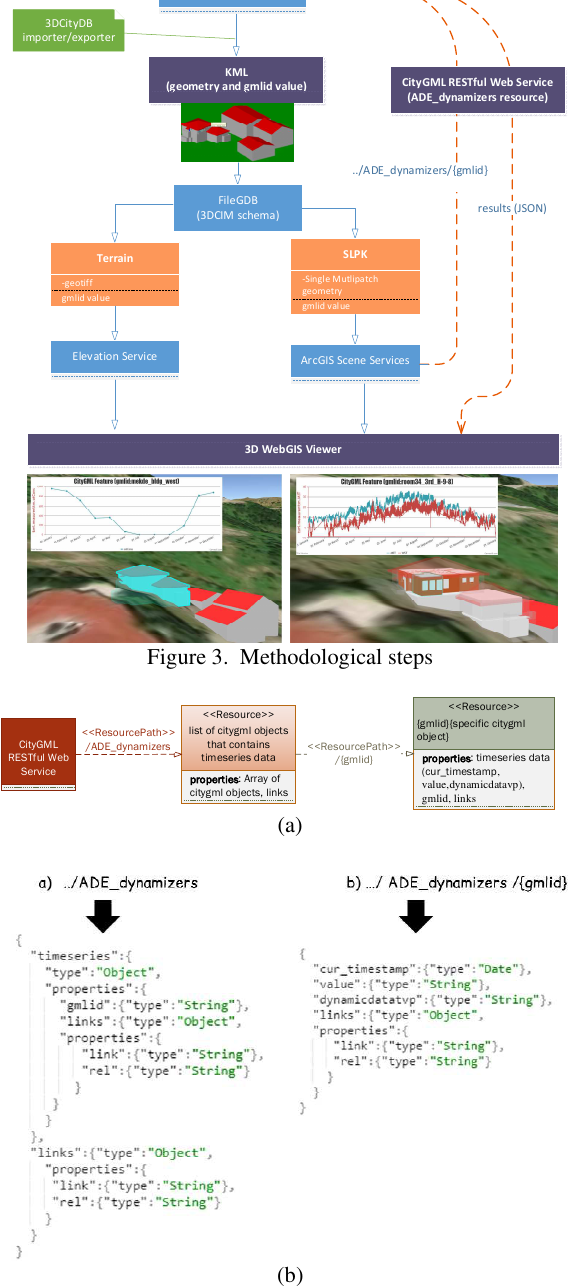
Figure 4. Conceptual model (a) and JSON-based schema (b)